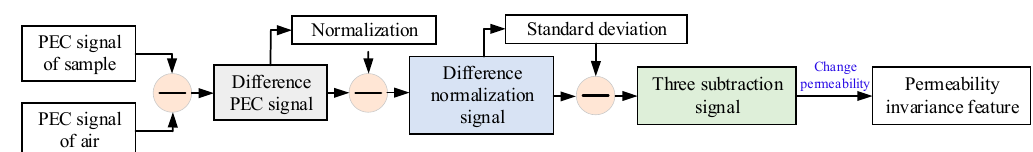
Figure 3. Flow diagram of thrice subtraction method.